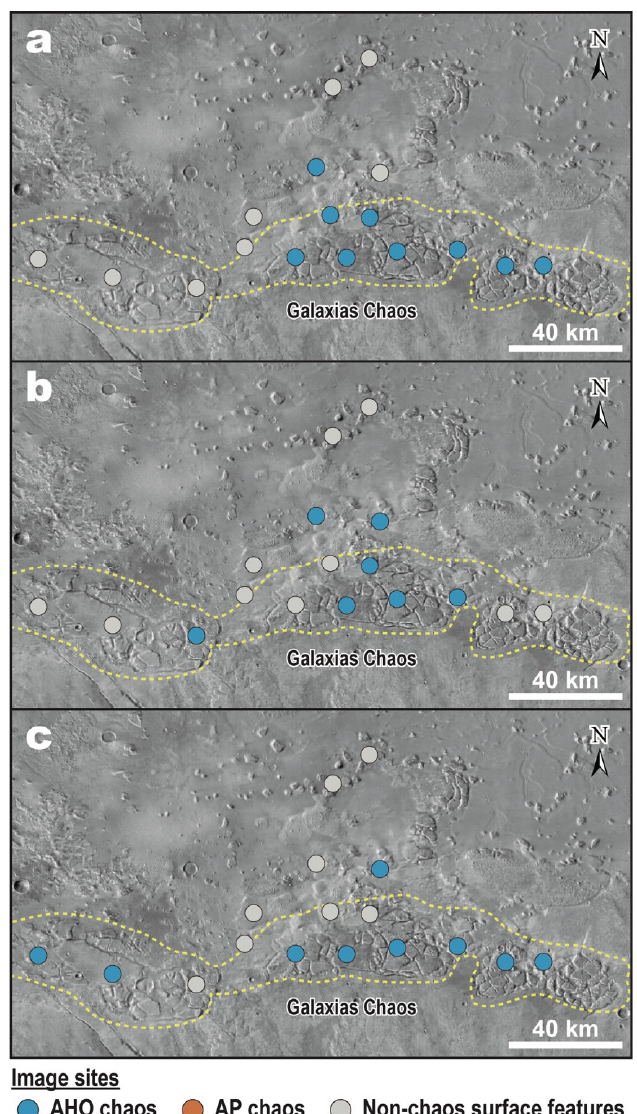
Figure 9. Classification results of chaos blocks (locations shown by circles) in the Galaxias Chaos region by the ( a ) CTX, ( b ) THEMIS, and ( c ) MOLA classifiers superimposed on a THEMIS daytime infrared image. Circle colors indicate the classification result (blue: AHO chaos blocks; orange: AP chaos blocks; gray: non-chaos surface features). Regions surrounded by yellow dotted lines are chaos-like features.